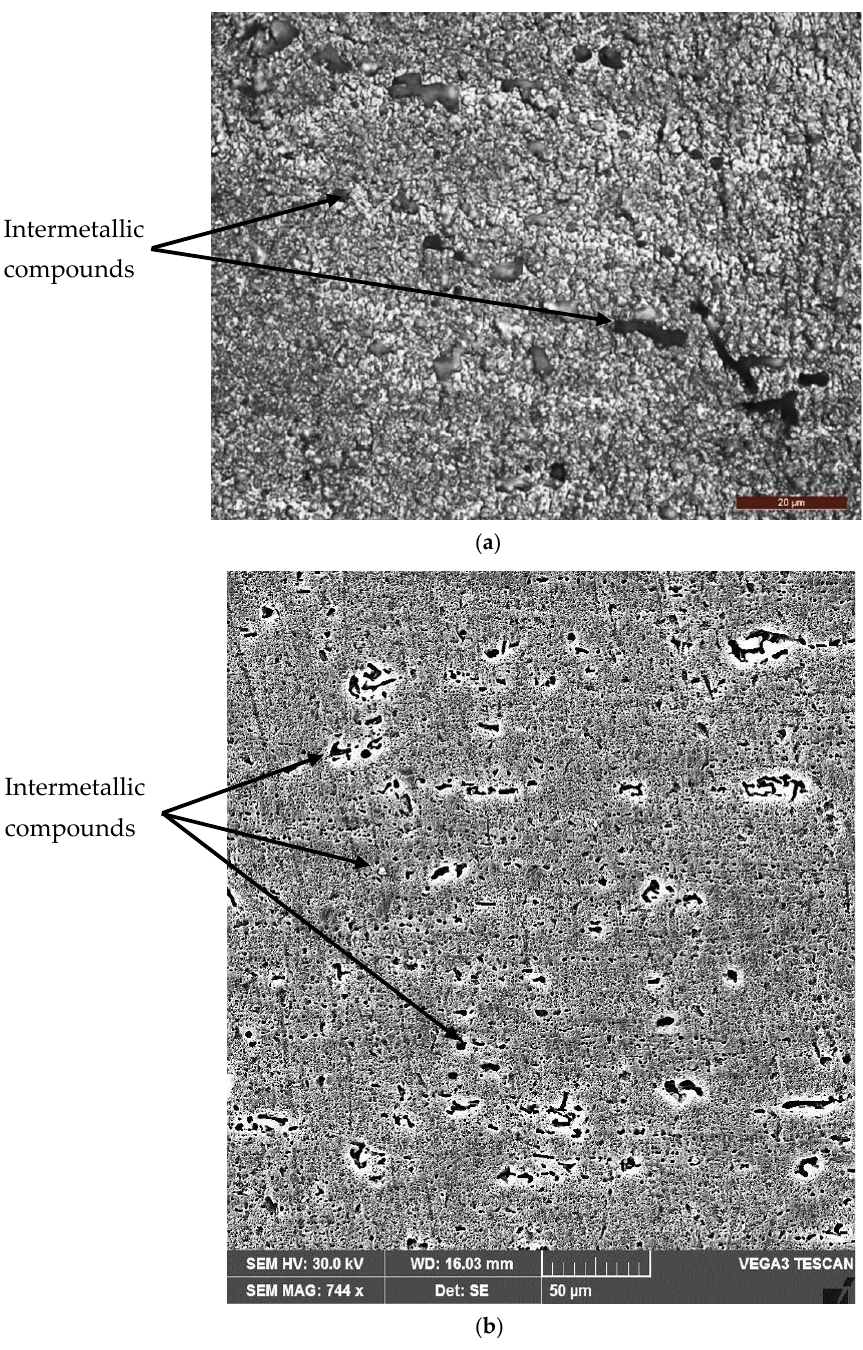
Figure 2. Microstructure of the alloy after solution heat treatment followed by artificial aging: ( a ) MO ×500; ( b ) SEM ×744.